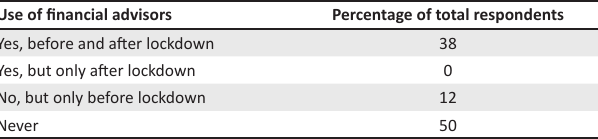
TABLE 7: The use of financial advisors before and after lockdown. Use of financial advisors Percentage of total